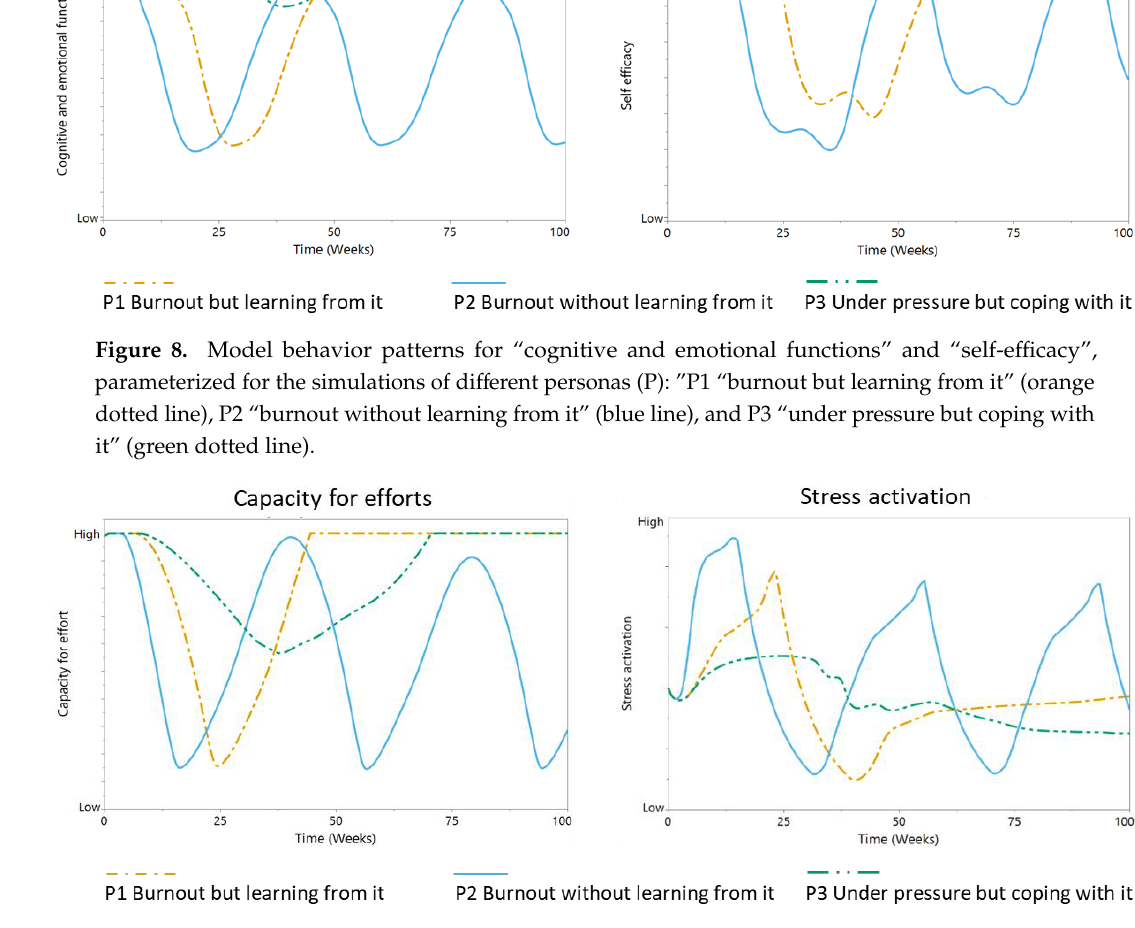
Figure 9. Model behavior patterns for “capacity for e ff ort” and “stress activation”, parameterized for the simulations of personas (P): P1 “burnout but learning from it” (orange dotted line), P2 “burnout without learning from it” (blue line), and P3 “under pressure but coping with it” (green dotted line). Simulated with VENSIM PLE©. V7.0.